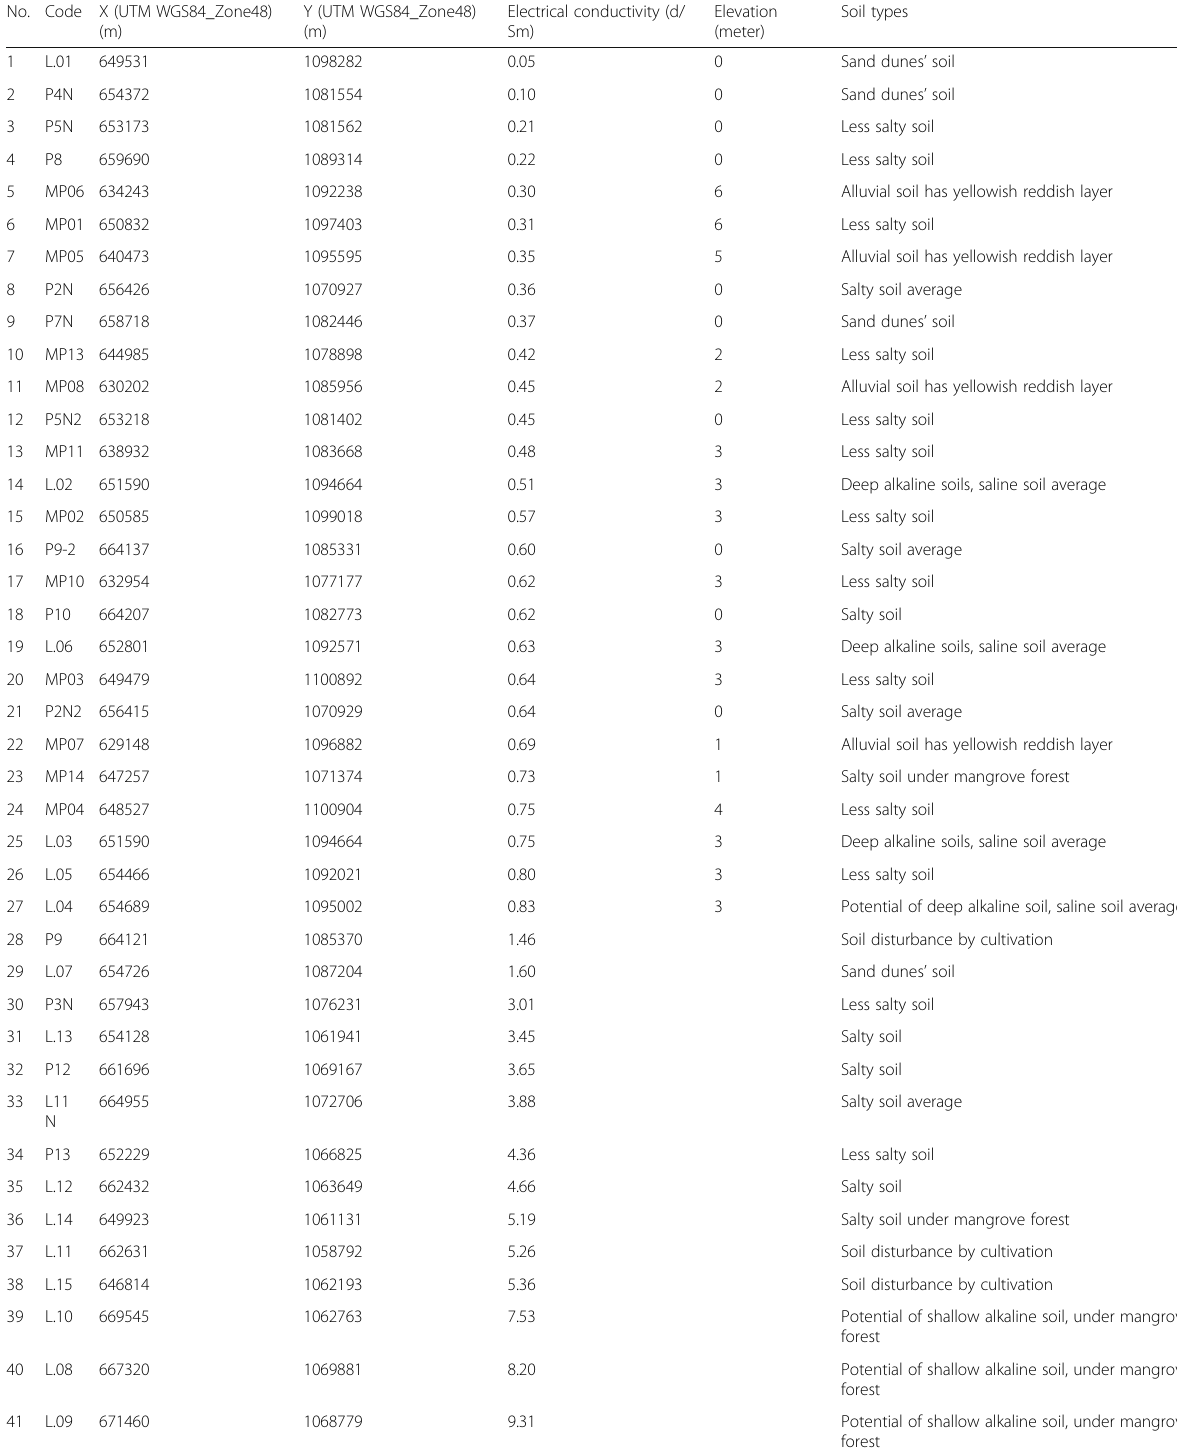
Table 4 Salinity information of 41 samples, among which 29 (~ 70%) samples are used for training and 12 (~ 30%) samples highlighted in gray color are used for